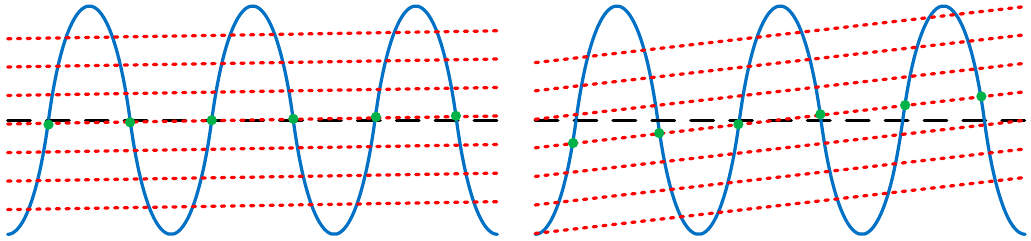
Figure 4. Conceptual illustration of layover. The two pictures are the schematic diagram when the incident angle is 1° ( left ) and 7° ( right ), respectively. The blue curve is the ‘real’ monochromatic wave height, the red dash line is the wavefront of the radar beam, and the green dots are the sea surface scattering elements on the same wavefront. The black dash line is the original mean SSH. That means all the green points will overlap into the same point during the imaging process, resulting in distortion of the sea surface.